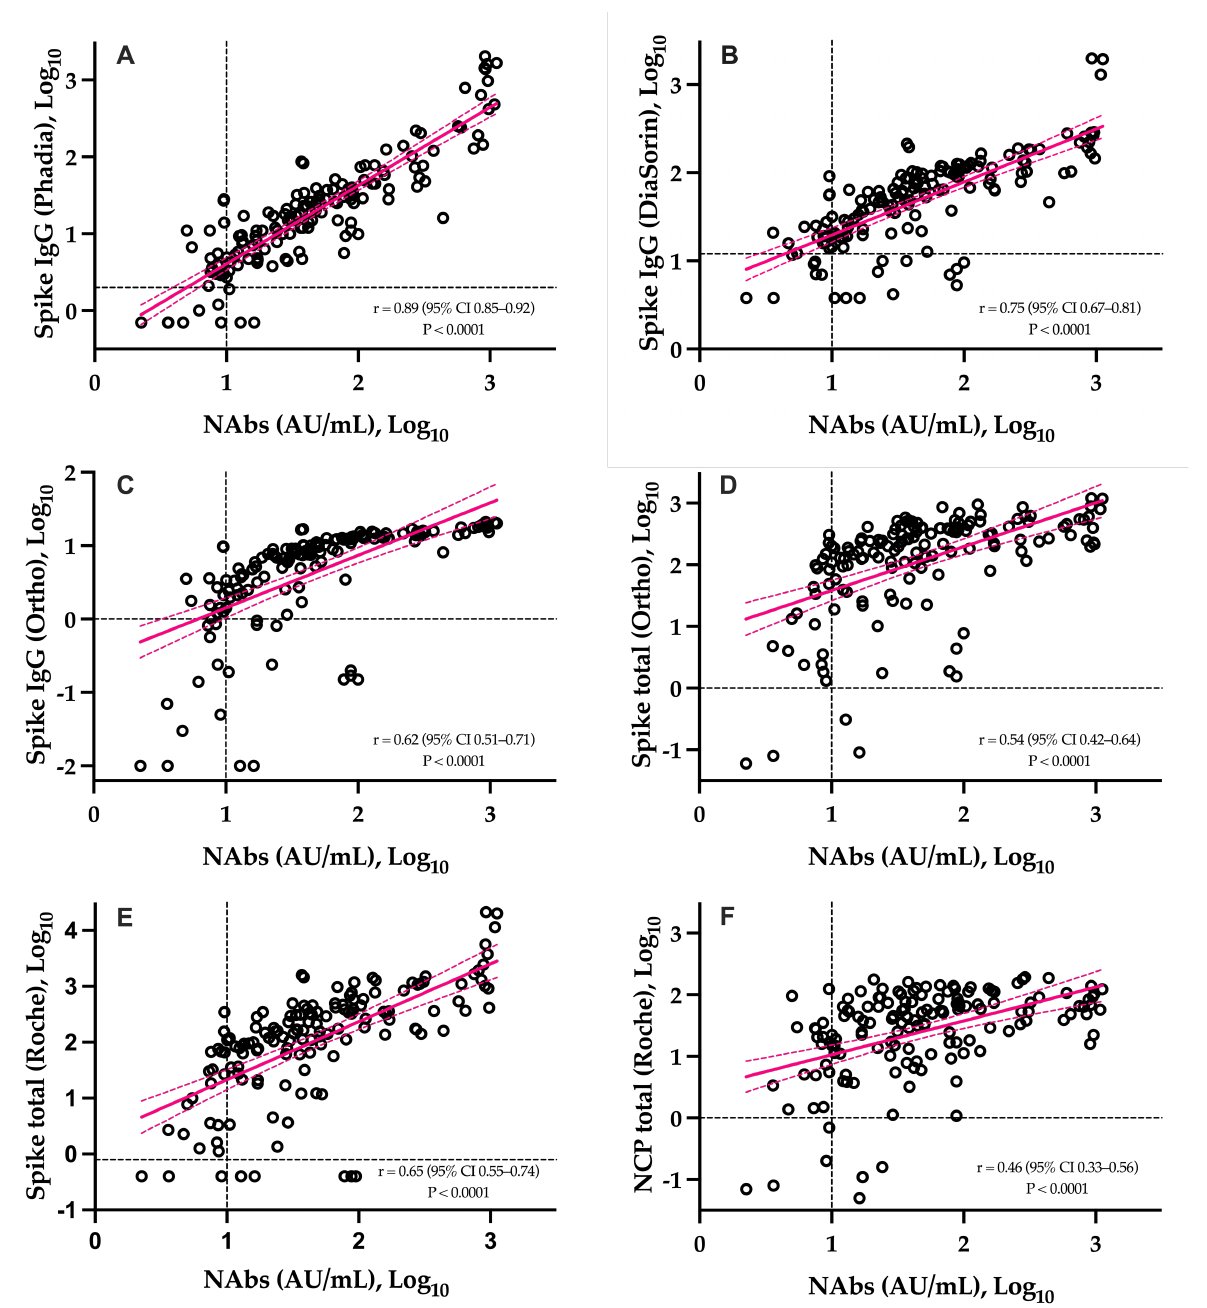
Figure 3. Head-to-head comparison of the sVNT to six different SARS-CoV-2 antibody assays. Black dotted lines correspond to the positivity threshold of each assay. ( A ): Phadia IgG spike assay; ( B ): DiaSorin IgG spike assay; ( C ): Ortho IgG spike assay; ( D ): Ortho total antibody spike assay; ( E ): Roche total antibody spike assay; ( F ): Roche total antibody nucleocapsid assay.